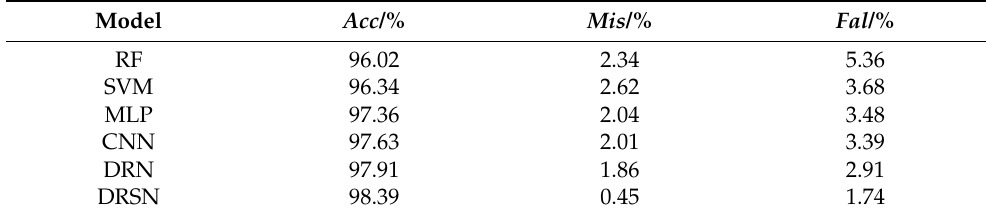
Table 3. Performance of different models on the IEEE 118-bus